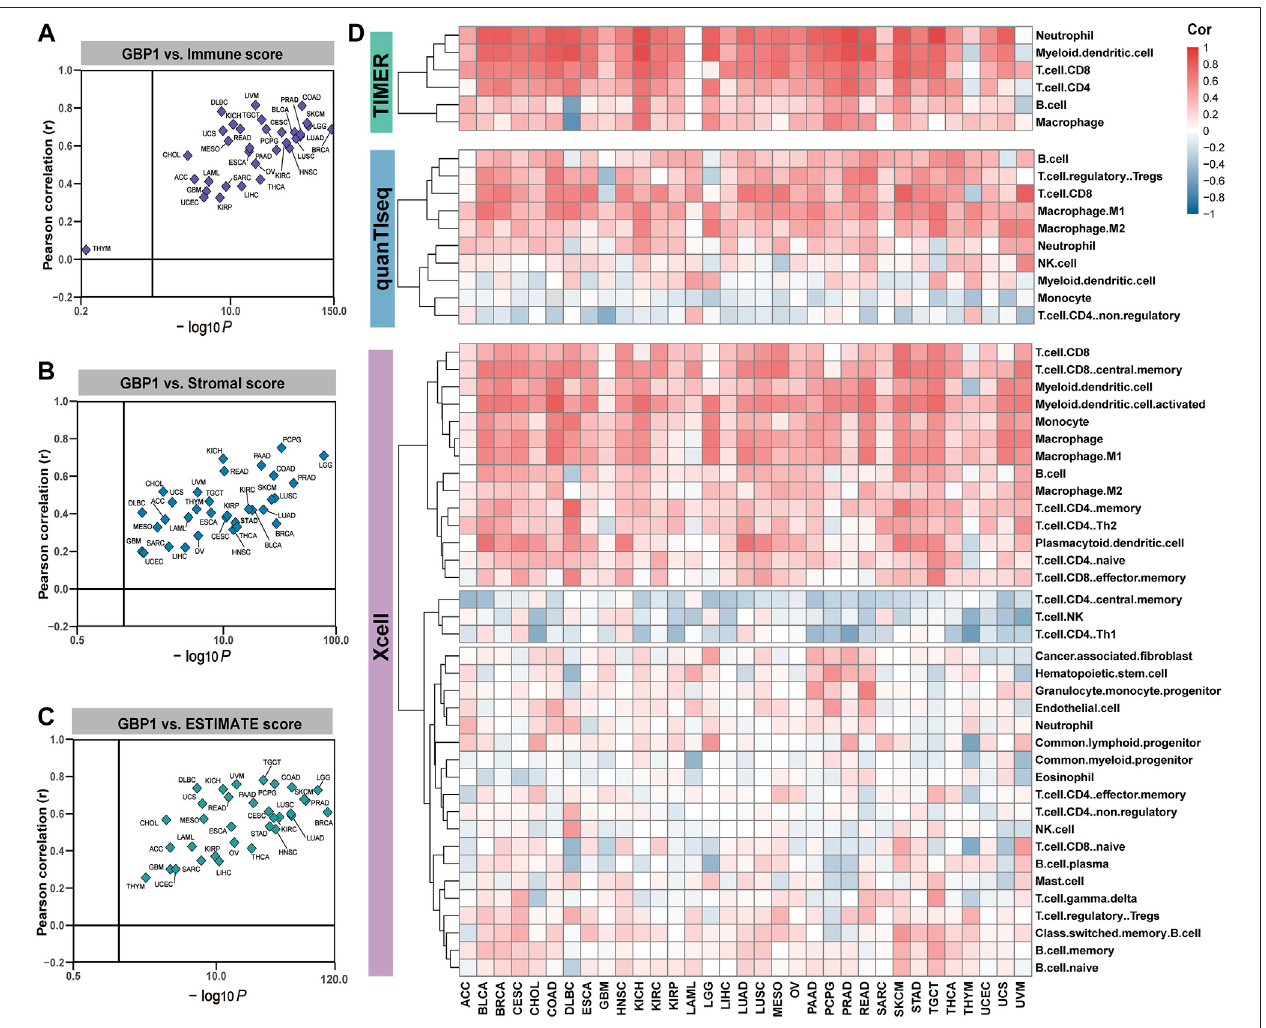
FIGURE 2 | correlation between GBP1 expression and immune cell in fi ltration. The correlation of GBP1 expression with immune (A) , stromal (B) , and ESTIMATE (C) scores across 33 cancer types. (D) The correlation between GBP1 expression and the in fi ltration level ofimmune cells across 33 cancer types calculated by TIMER, xCell, and quanTIseq algorithms. Blue represents negative Spearman correlation coef fi cients and red represents positive ones.